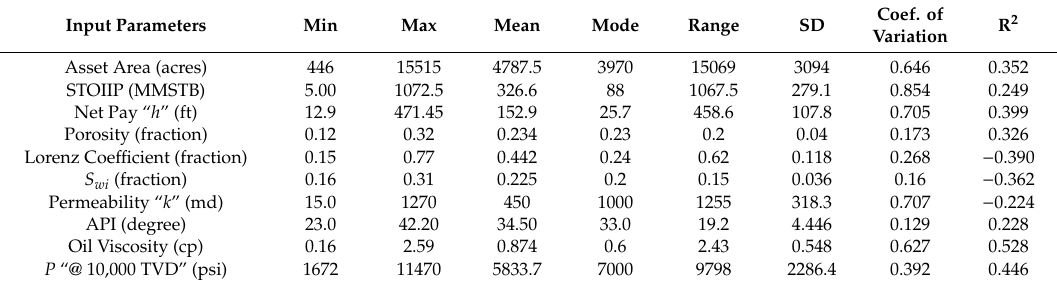
Table 2. The statistical description of the data used to train the AI models developed in this study.